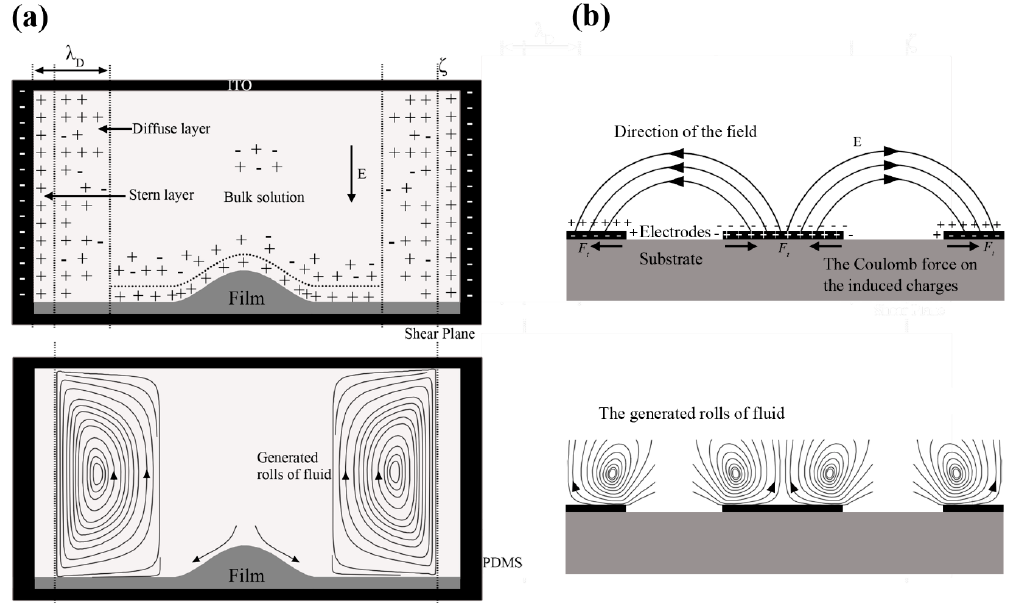
Figure 4. The formation mechanism of the ACEO in the 3D ( a ) and 2D ( b ) electrode system.